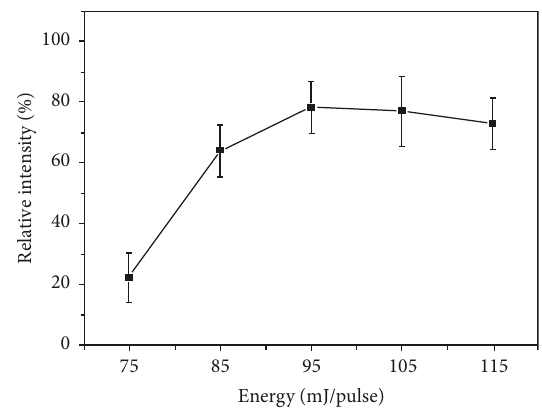
Figure 2: The dependence of the signal at m / z 520.5093 on laser